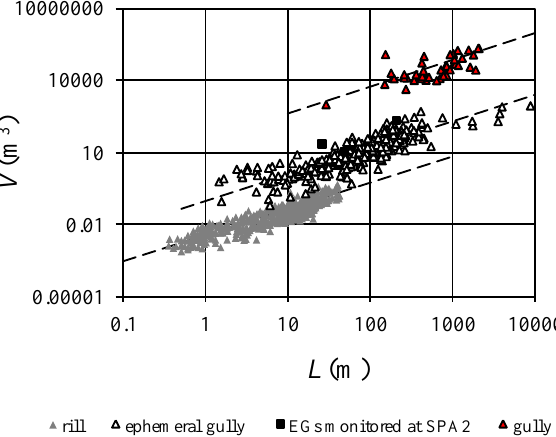
Figure 14. Relationship between the total length, L , and the total volume, V , for rills, EGs, and gullies (modified from [1]).